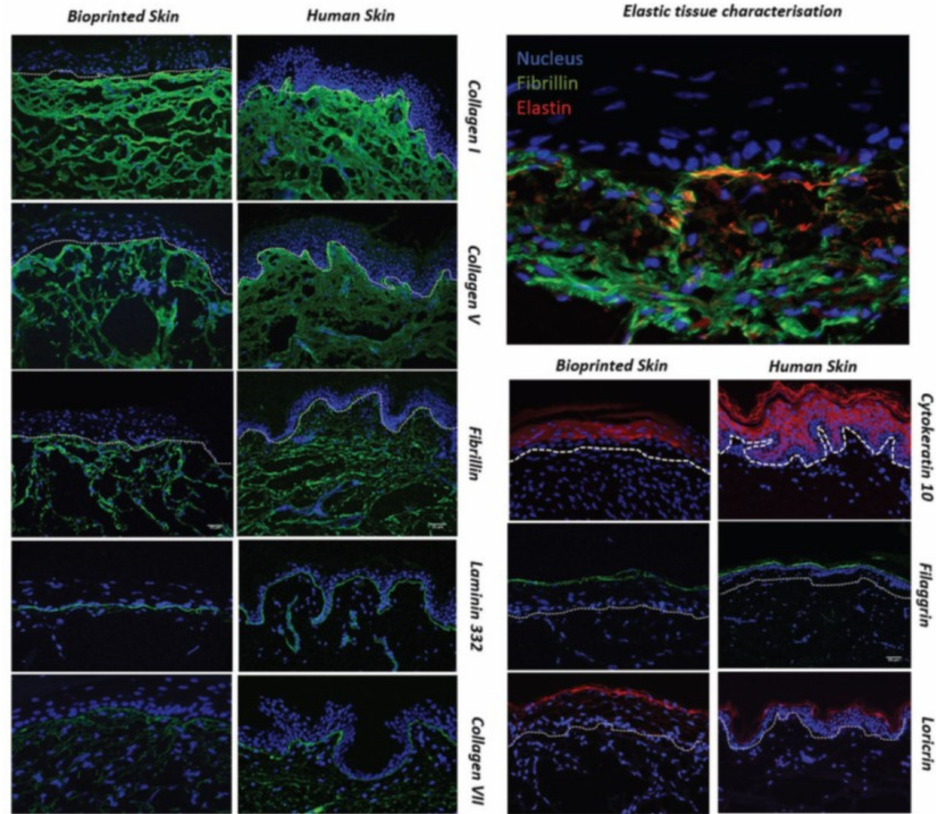
Figure 14. Epidermal differentiation and dermal markers’ profiles of bioprinted skin in comparison to normal human skin from a healthy donor. Fluorescent microscopy observations. Reproduced from [232] with permission from John Wiley and Sons,